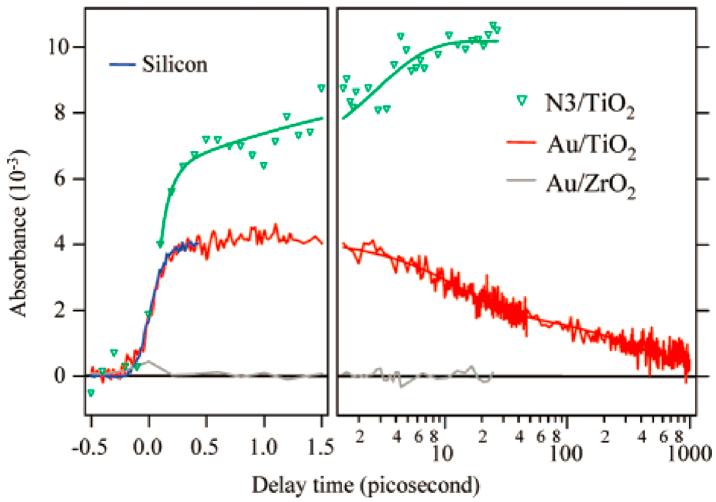
Figure 2. Transient absorption of N 3 /TiO 2 , Au/TiO 2 and Au/ZrO 2 at 3500 nm [15].